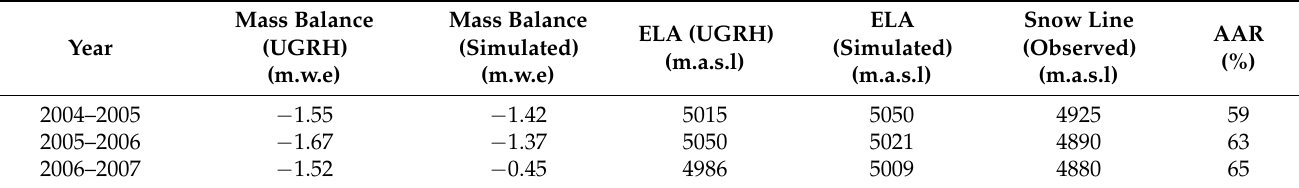
Table 4. Annual simulated and UGRH measured [35] mass balances and ELAs, observed snow line [47] and calculated accumulation-area ratio from simulated